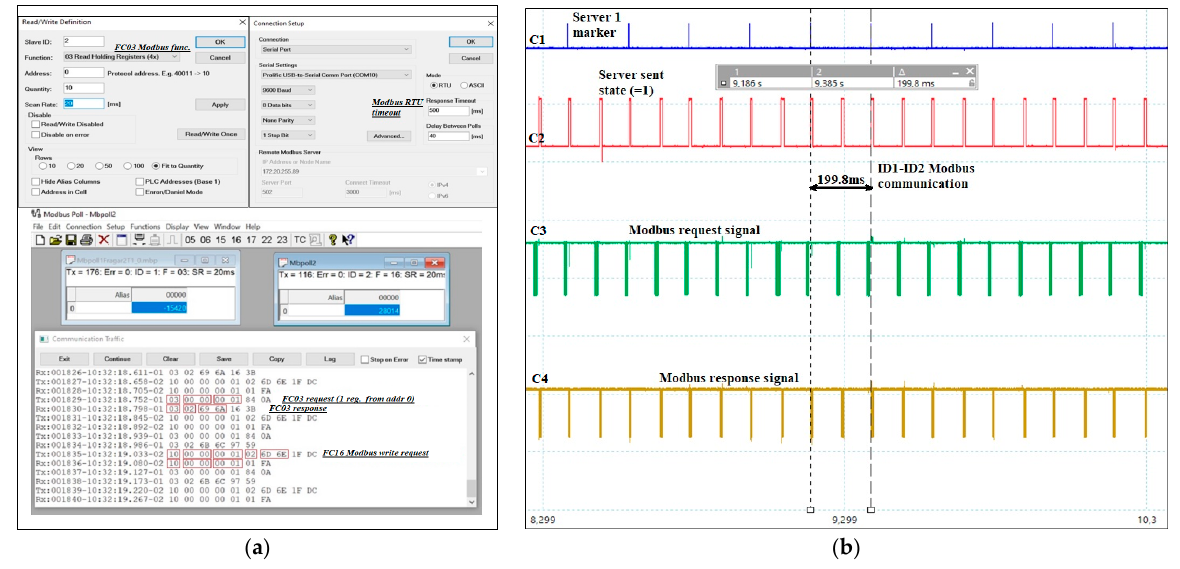
Figure 4. Modbus protocol performance analysis: ( a ) Modbus connection parameterization, FC03 and FC16 function definitions and Modbus Poll interface (read/write Modbus function (0x03/0x10), start address (0x00, 0x00), number of registers (0x00, 0x01), byte counter 0x02, register data (0x69, 0x6A/0x6D, and 0x6E), and CRC); ( b ) experimental data for Modbus acquisition cycles analyzed in experimental laboratory project (39 servers) using PICOSCOPE 6404D (Pico